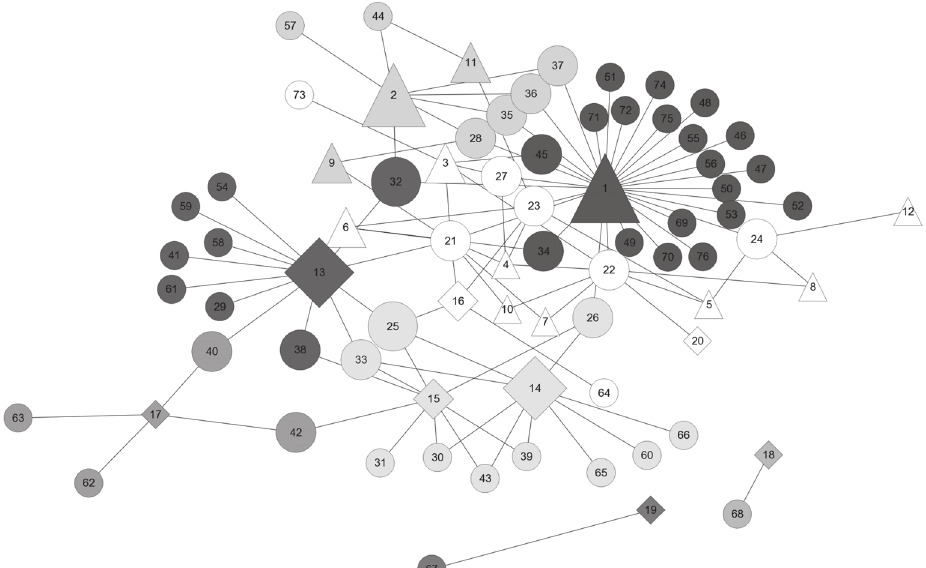
Figure 1. The structure of the mixed bipartite seed dispersal network from Coimbra Forest, northeastern Brazil, was more modular than nested, with a strong separation between bats (triangles) and birds (diamonds), and their food-plants (ellipses) in different modules (identified by grey tones). The most important frugivore and plant species (larger symbols) were located in the center of some modules (hubs) or bound together different modules (connectors). Symbol size is proportional to network functional role. Species codes are presented in Table